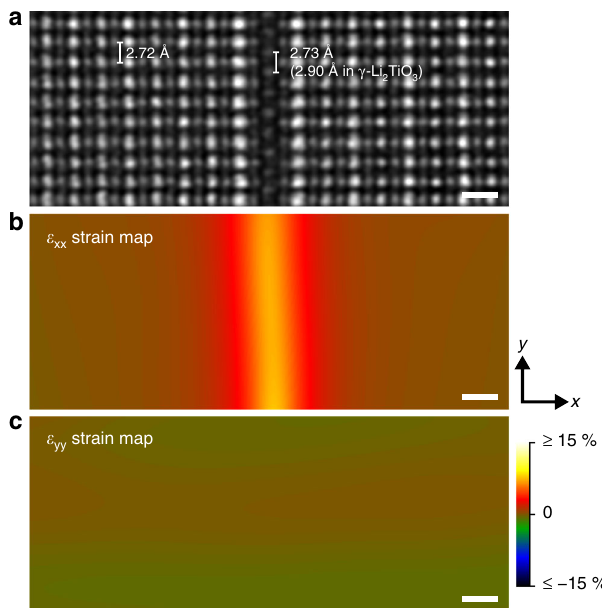
. b , c ε xx ( b ) and ε yy p